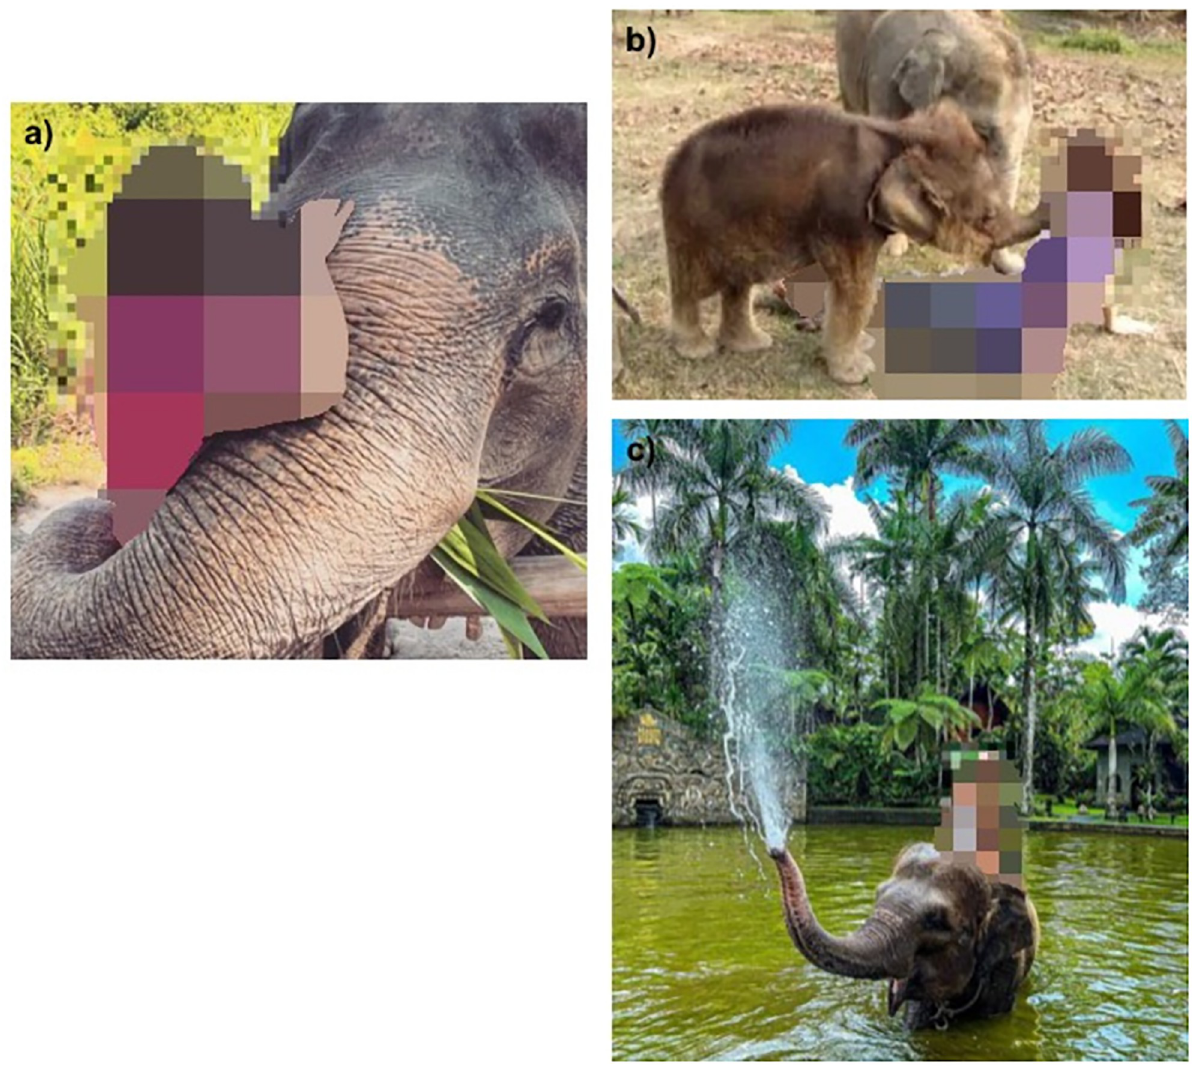
Fig 2. Example Instagram screenshots showing ‘elephant selfie’ images using the hashtags #elephantselfie (a, b), and #elephantride (c).